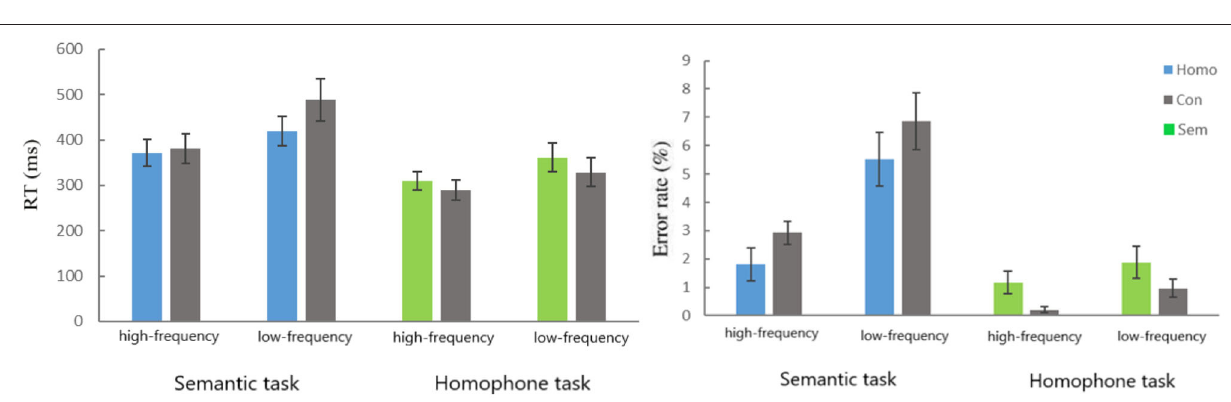
FIGURE 2 | Mean response times (RT) and error rates for the 2 types of trials in both the semantic task and the homophone task (error bars indicate standard